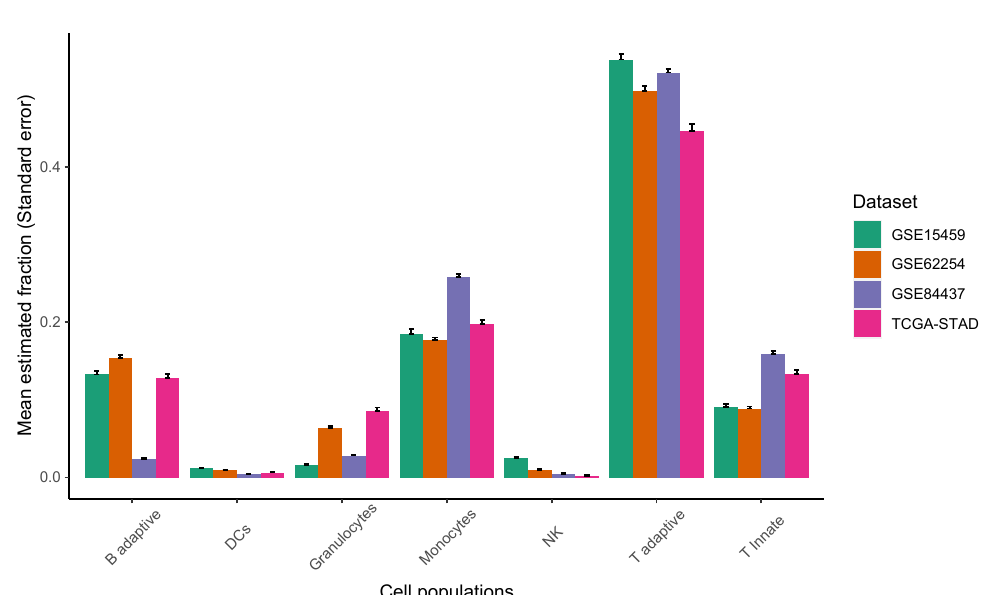
Figure 4. The relative abundance of major classes of immune cell populations for four cohorts of gastric cancer samples.